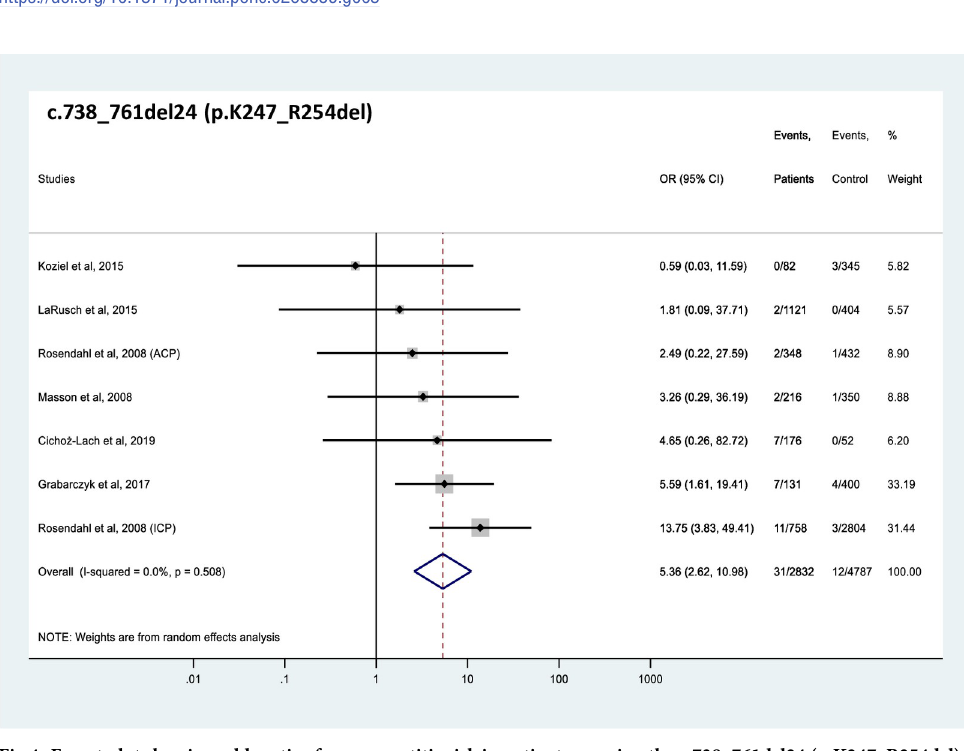
Fig 4. Forest plot showing odds ratios for pancreatitis risk in patients carrying the c.738_761del24 (p.K247_R254del) CTRC variant. OR, odds ratio; CI, confidence